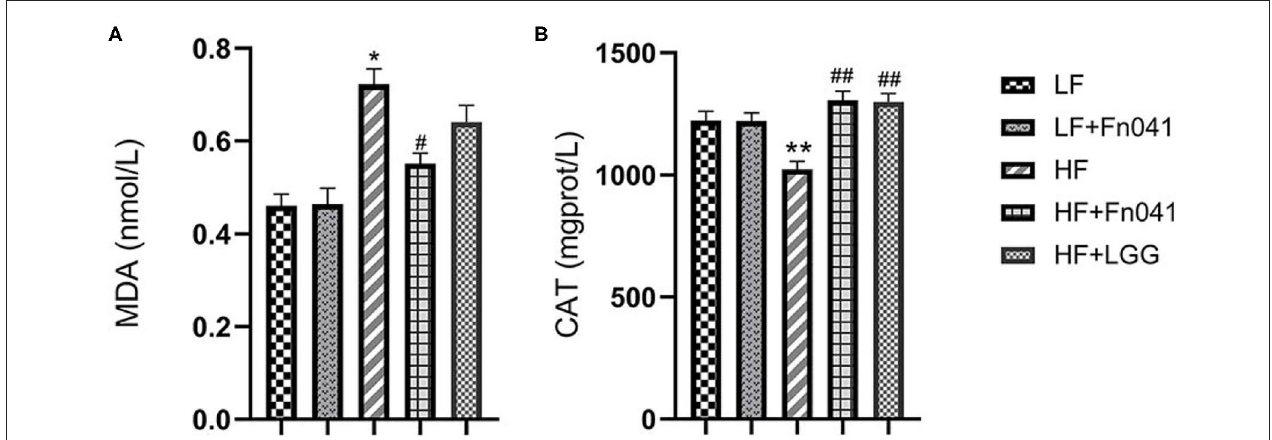
FIGURE 3 | Effects of Lactobacillus reuteri Fn041 on oxidative stress in the liver. (A) MDA level; (B) CAT activity; Data are presented as mean ± SEM ( n = 12/group); * p < 0.05, ** p < 0.01 as compared with the LF group; # p < 0.05, ## p < 0.01 as compared with the HF group. LF, low-fat diet group; LF + Fn041, low-fat diet group treated with L. reuteri Fn041; HF, high-fat diet group; HF + Fn041, high-fat diet group treated with L. reuteri Fn041; HF + LGG, high-fat diet group treated with Lactobacillus rhamnosus GG. CAT, Catalase; MDA,